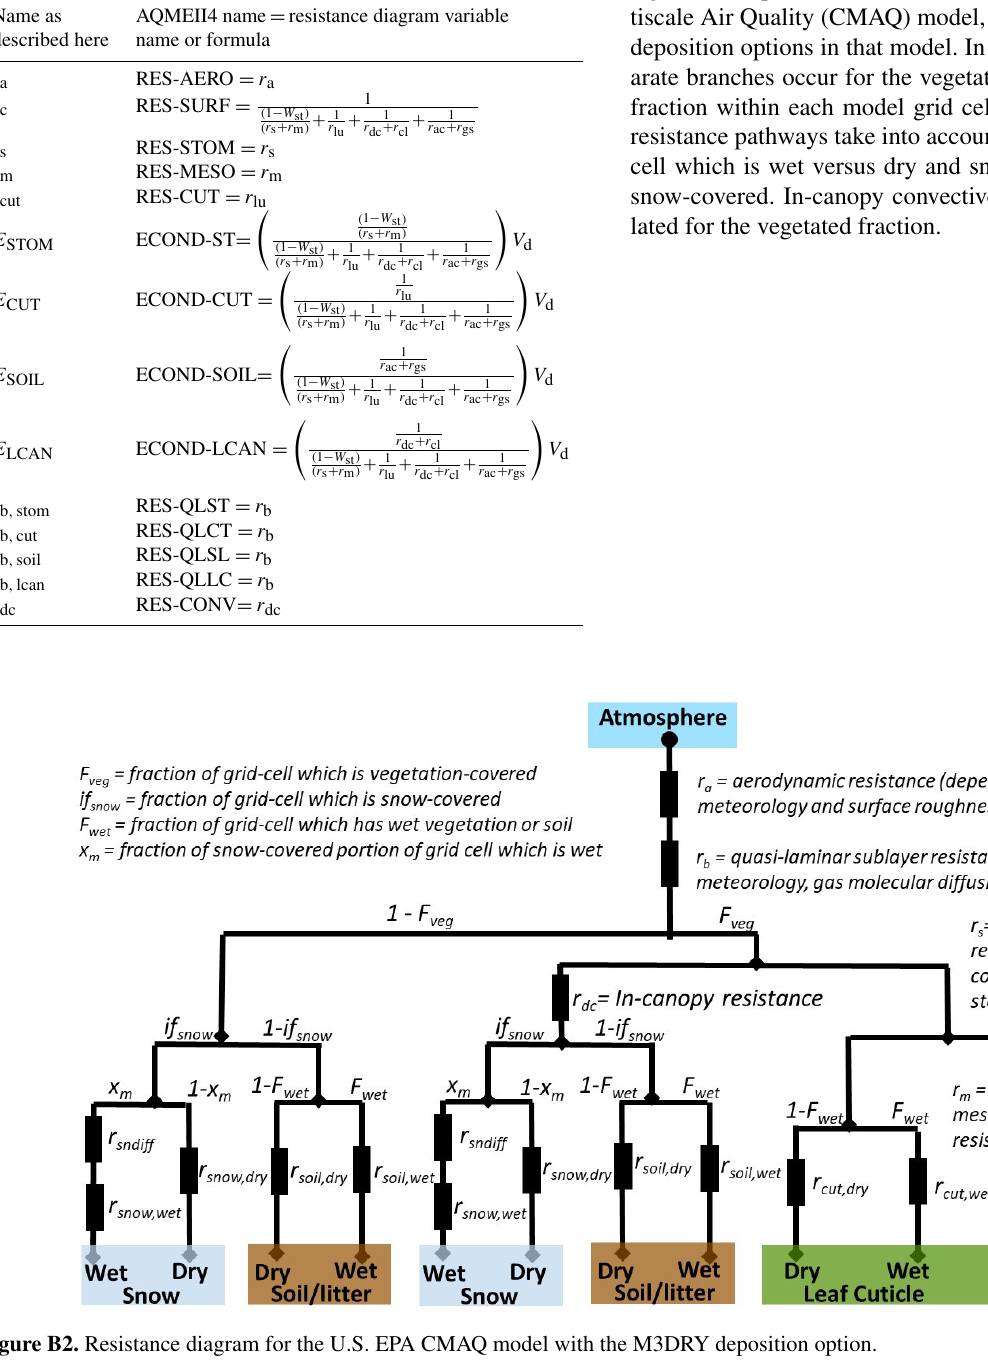
Figure B2. Resistance diagram for the U.S. EPA CMAQ model with the M3DRY deposition